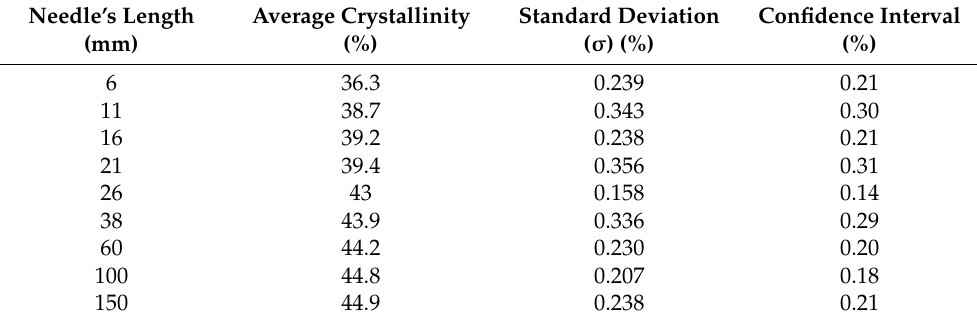
Table 1. The crystallinity of PVA membranes obtained by different needles. Needle’s